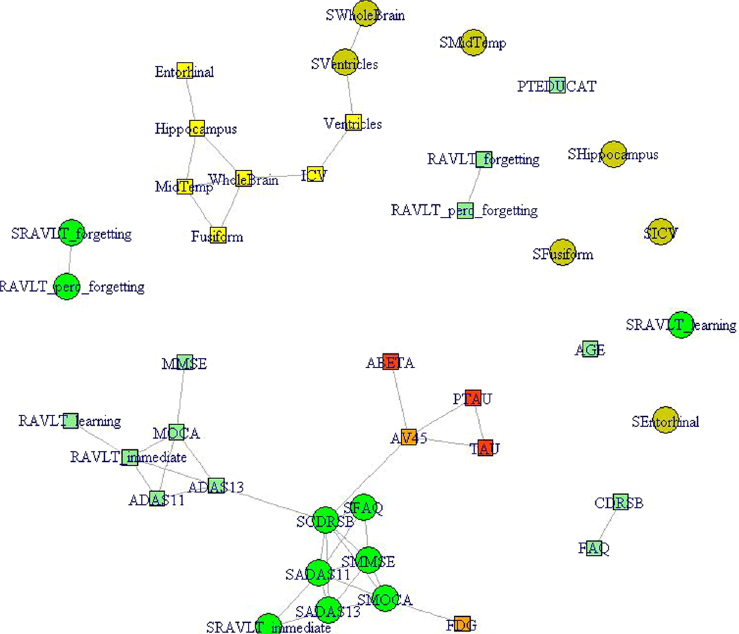
Figure 1. Correlation Network between clinical and biomarker variables in all MCI subjects. The network Baseline descriptors are denoted by squares while circles are used to denote longitudinal rate of change (slope) descriptors. Green color depicts cognitive and functional variables with squares depicting baseline values and circles depicting rate of change values. Yellow squares depict baseline MRI volumetric measures while yellow circles depict slope of MRI volumetric changes over time. Orange squares represent baseline brain FDG-PET and AV45PET data while red squares represent baseline spinal fluid amyloid-beta, total- tau and phosphorylated-tau data. See Methods for details of the measurements. The length of the edges is inversely proportional to the strength of the correlation. Only Spearman’s correlations rho > 0.5 are shown as edges. Slopes are denoted with the prefix alphabet “S” in front of the test name. FAQ = Functional Activities Questionnaire; ADAS11 and ADAS13 reflect the 11-item and 13-item versions of this test. MOCA = Montreal Cognitive Assessment Scale; Other details are described in the